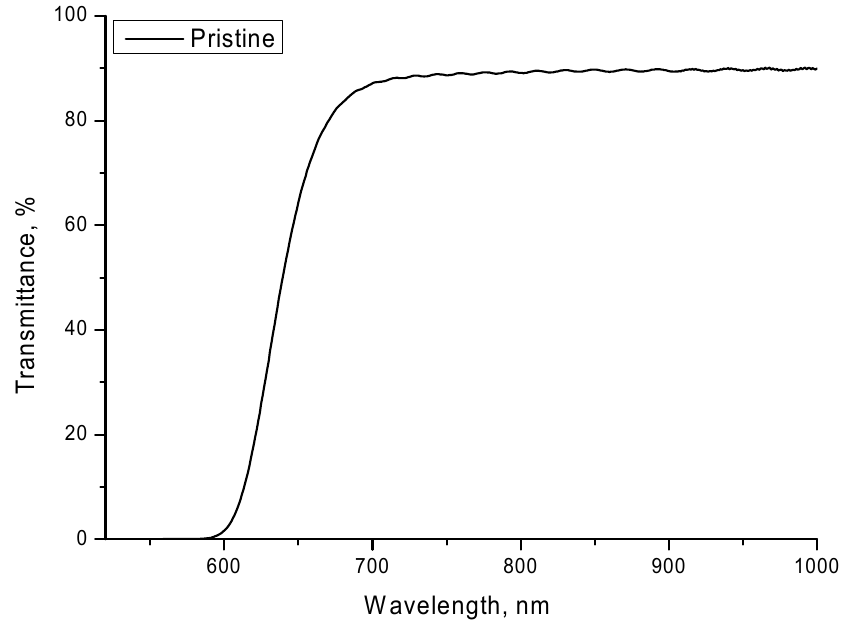
Figure 1. Transmittance change results of initial film LR-115 type 2 (the presented data were obtained with the correction for Fresnel loss, by measuring the reference spectra).